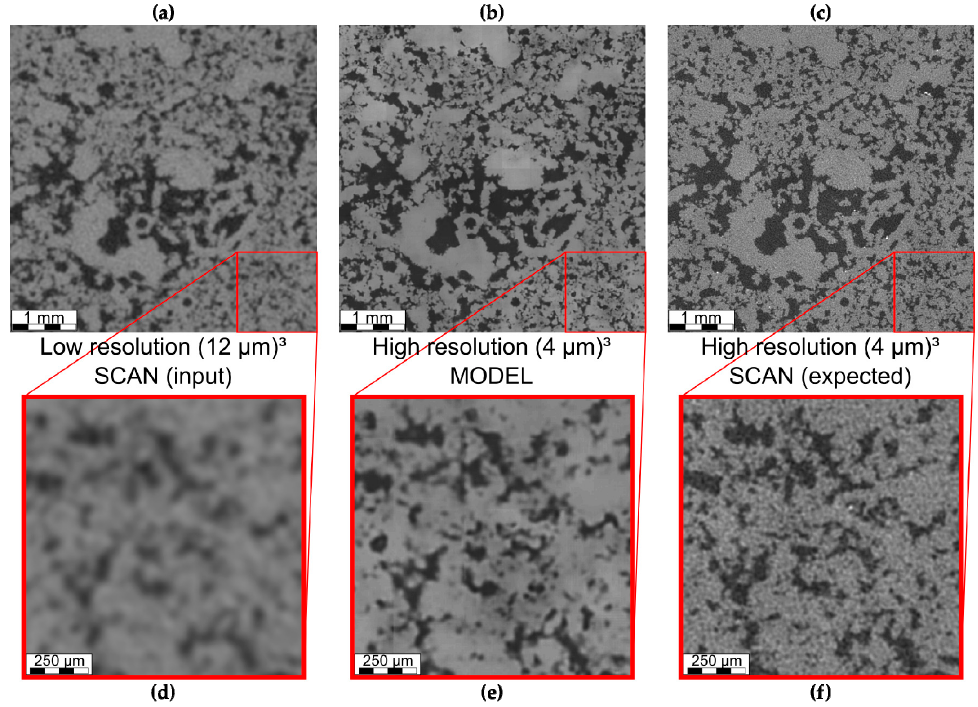
Figure 4. Visual results comparing the low resolution (LR) input ( a , d ) to the output (SRM) of the super-resolution GAN ( b , e ) and to the expected high resolution (HR) output ( c , f ). The blurriness of LR has disappeared in SRM and small pores are more clearly delineated, similar to HR. Furthermore, both LR and HR contain noise, which has disappeared in the SRM. However, SRM and HR do not have a one-to-one